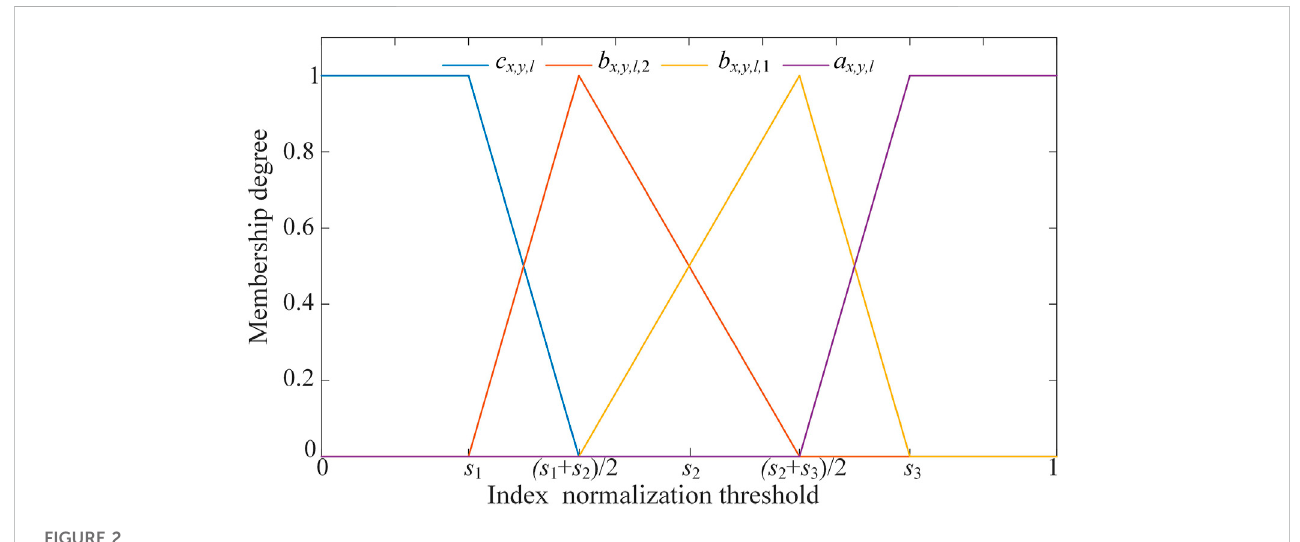
FIGURE 2 Schematic diagram of correlation degree and threshold.